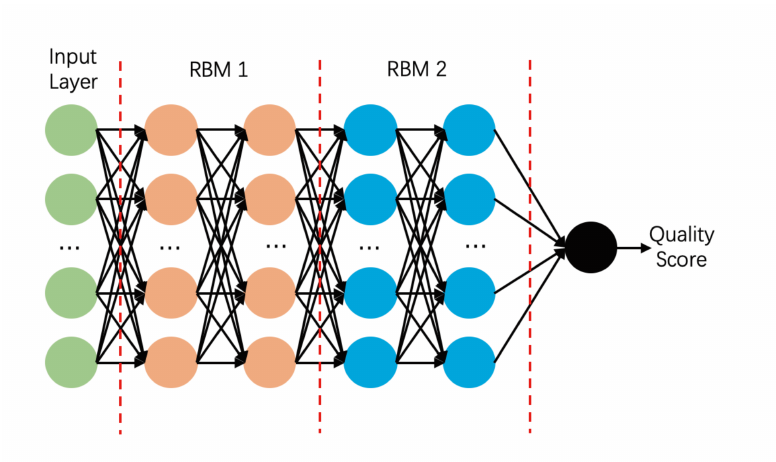
Figure 6. Structure of DeepQA. The neurones in each restricted Boltzmann machine (RBM) are independent and unconnected within the layers, but fully connected between the